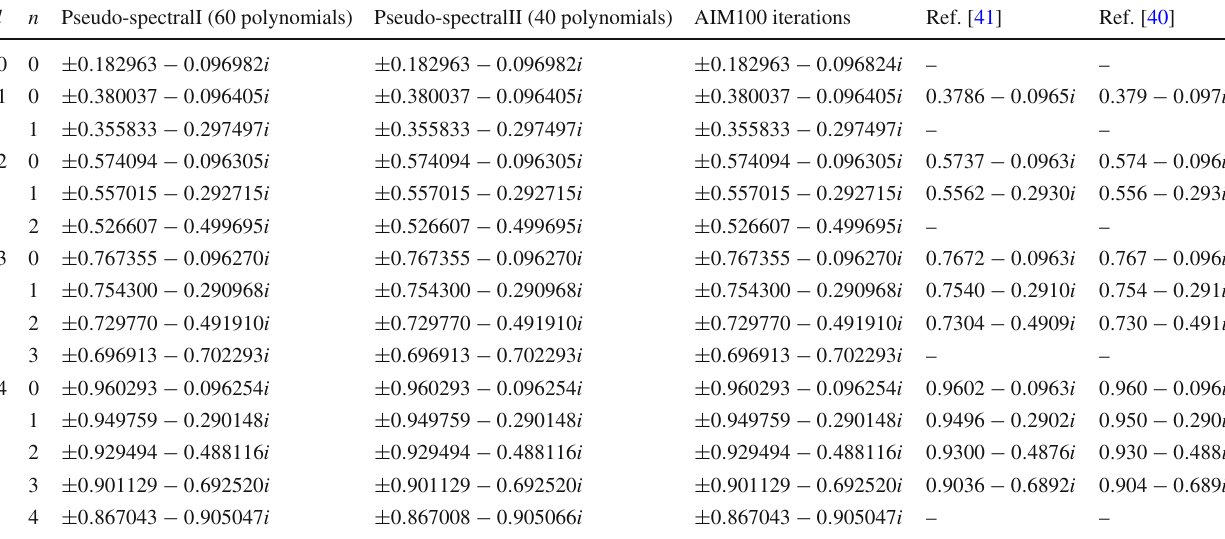
Table 4 Quasinormal frequencies of the spin 1 / 2 perturbations normalized by the mass ( M ω) compared against the results of Refs. [40,41] l n Pseudo-spectralI (60 polynomials) Pseudo-spectralII (40 polynomials) AIM100 iterations